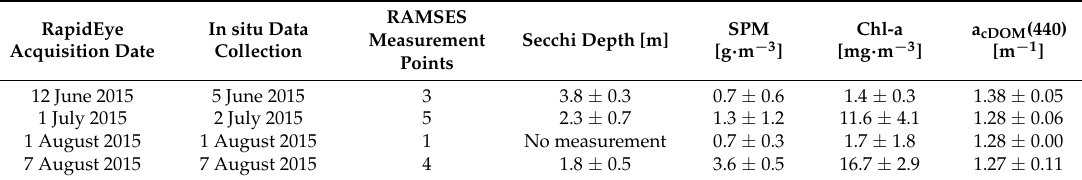
Table 2. Average water constituent concentrations and number of measurement points at in situ campaigns close or concurrently to RapidEye data